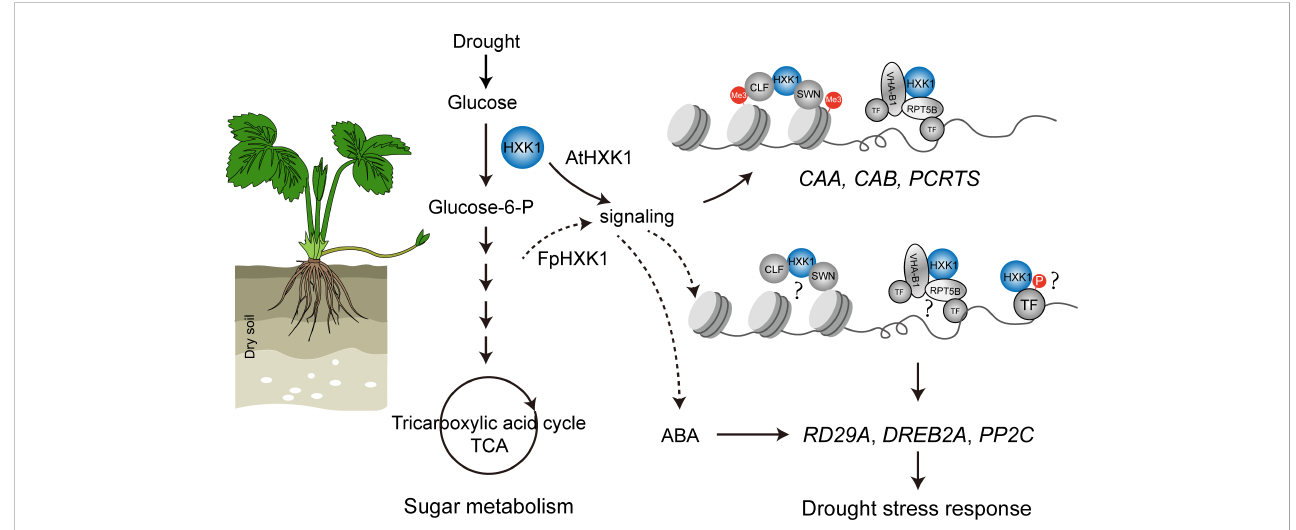
FIGURE 9 A schematic diagram showing the mechanism through which the FpHXK1 participates in drought stress response and sugar metabolism in strawberry plants. Me3: histone H3 lysine27 trimethylation (H3K27me3); CAA, carbonic anhydrase; CAB, chlorophyll a/b binding protein; PCRTS, CLF, Curly Leaf; SWN, Swinger; VHA-B1, Vacuolar proton pump subunit; RPT5B, 19S regulatory particle of proteasome subunit; TF, Transcription factors; DREB2A, Dehydration-responsive element binding protein2a; PP2C, Protein phosphatases type